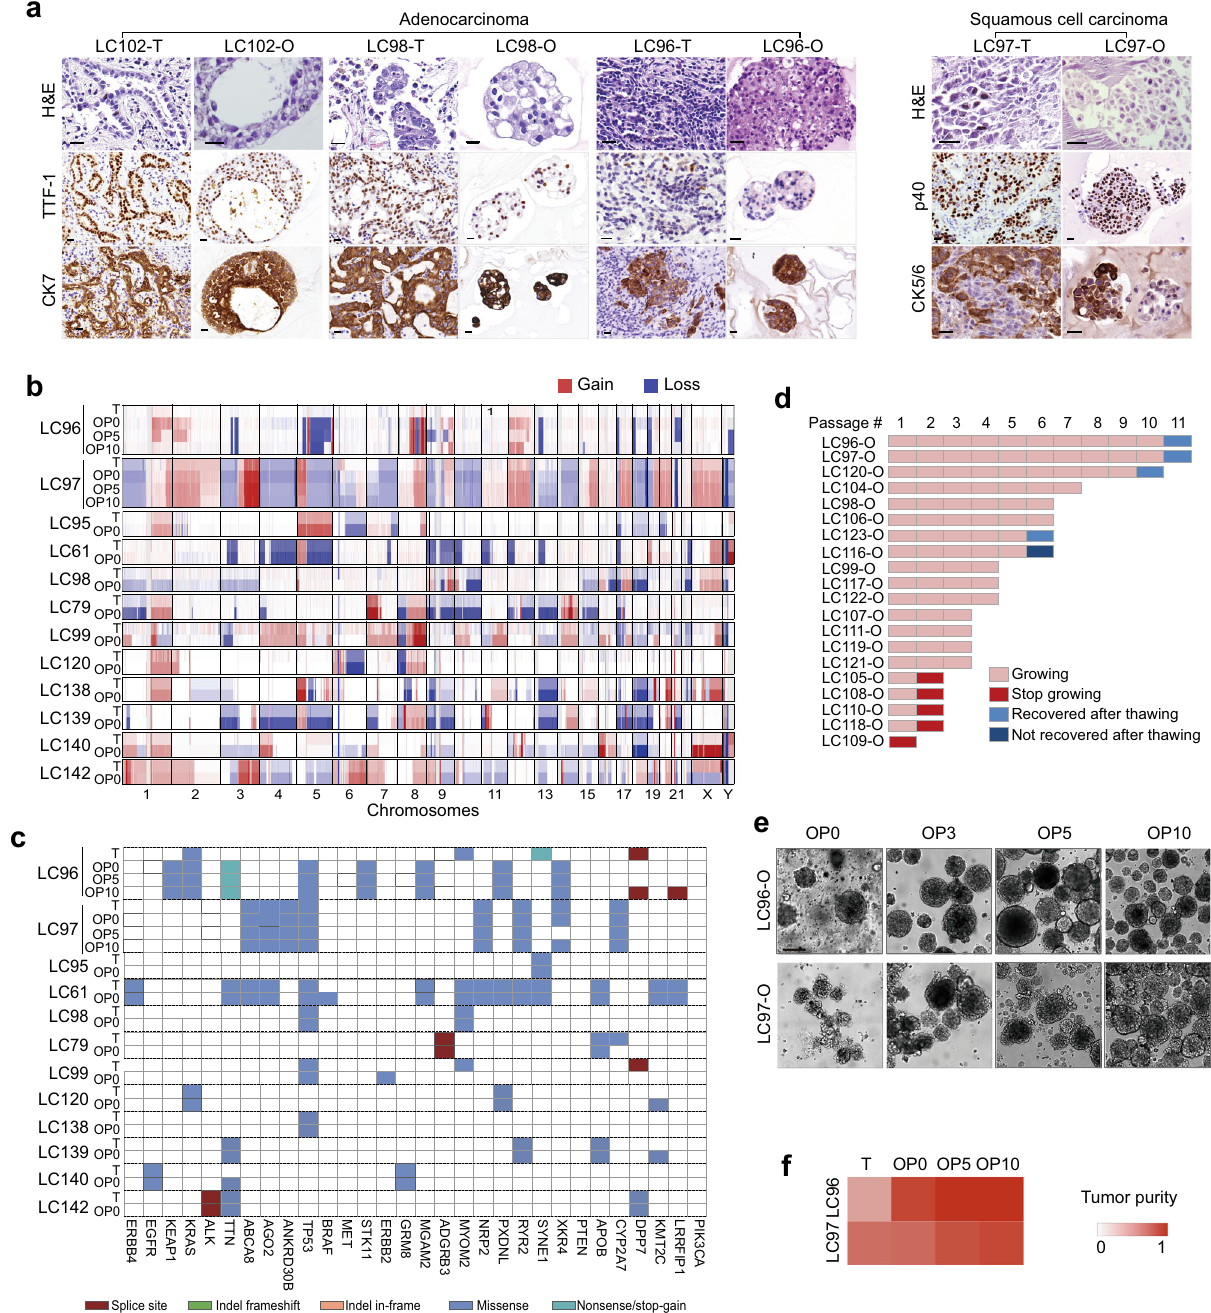
Fig. 2 Characterization of lung cancer organoids. a H&E and immunohistochemical staining images of lung cancer tissues and derived organoids. Shown are representative examples of LAC with acinar (LC102 and LC98) or solid (LC96) subtypes and LSC (LC97). The LCOs retained the tumor cell organizations and the expression patterns of the characteristic markers (TTF-1 and CK7 for LAC, p40, and CK5/6 for LSC). Scale bars, 20 µ m. The experiments are repeated three times. b Heat map illustrating genome-wide copy number variations (CNVs) of lung cancer tissue – LCO pairs. DNA copy number gains (red) and losses (blue) found in the original lung cancer tissues are conserved in the corresponding tumor organoids. Signal ampli fi cation can be seen in all the LCOs compared to the original tumor tissues (T tissue, O organoids). c Overview of somatic mutations in cancer genes found in the tissue-organoid pairs. Shown is the most severe mutation per gene. d Stacked bar graphs illustrating the numbers of passages and the freeze – thaw status of 20 LCO lines underwent long-term culture. Each block indicates one passage or a freeze – thaw cycle. For example, LC96-O and LC97-O have been passaged more than ten times and successfully thawed after frozen at passage 10. LC116-O has been passaged fi ve times but failed to recover after frozen. LC105-O stopped growing at passage 2. e Bright- fi eld images showing the unchanged morphologies of LC96-O and LC97-O at P0, P3, P5, and P10. Scale bar, 200 µ m. The experiments are repeated three times. f Heat map showing the increasing purities of tumor cells with passaging in LC96-O and